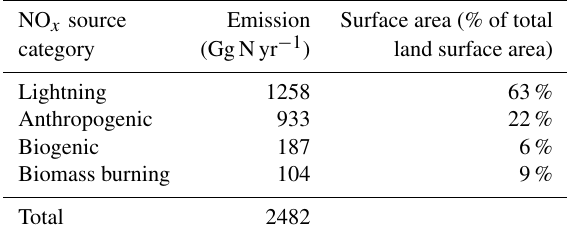
Table 2. Total NO x emissions in the WRF-Chem domain per source category using January 2014 emissions to infer yearly total NO x emissions (GgNyr − 1 ). The percentage of surface area over land where the emission source is dominant is also indicated. NO x